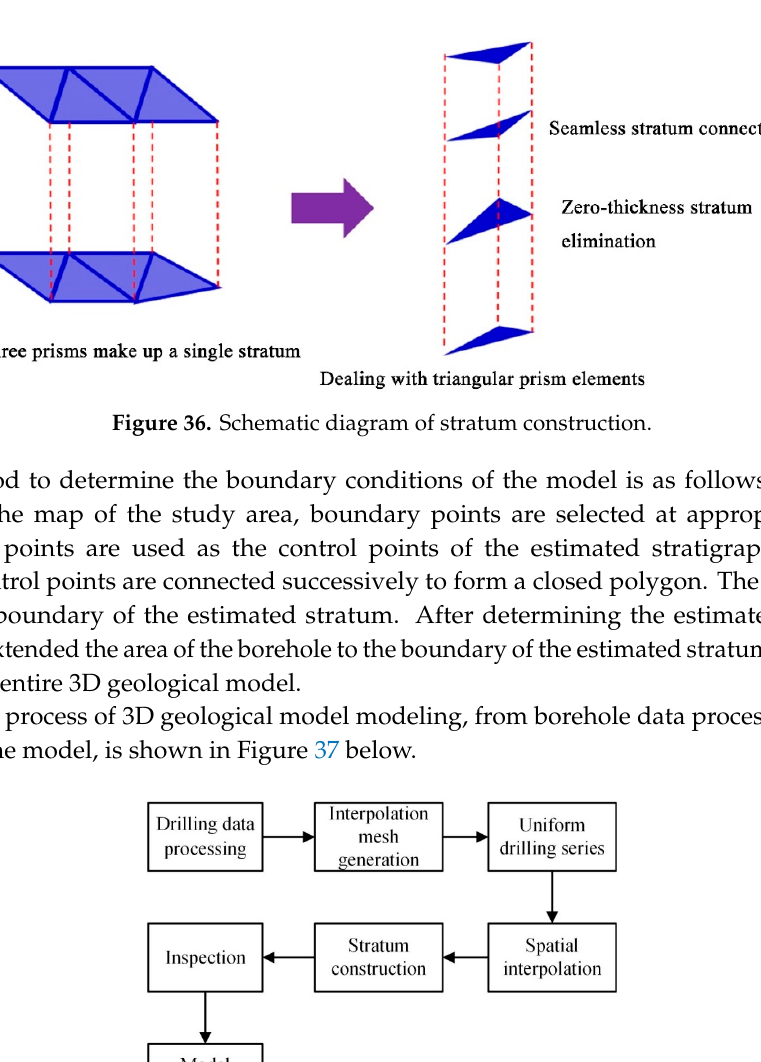
Figure 37. Workflow of 3D geological modeling.